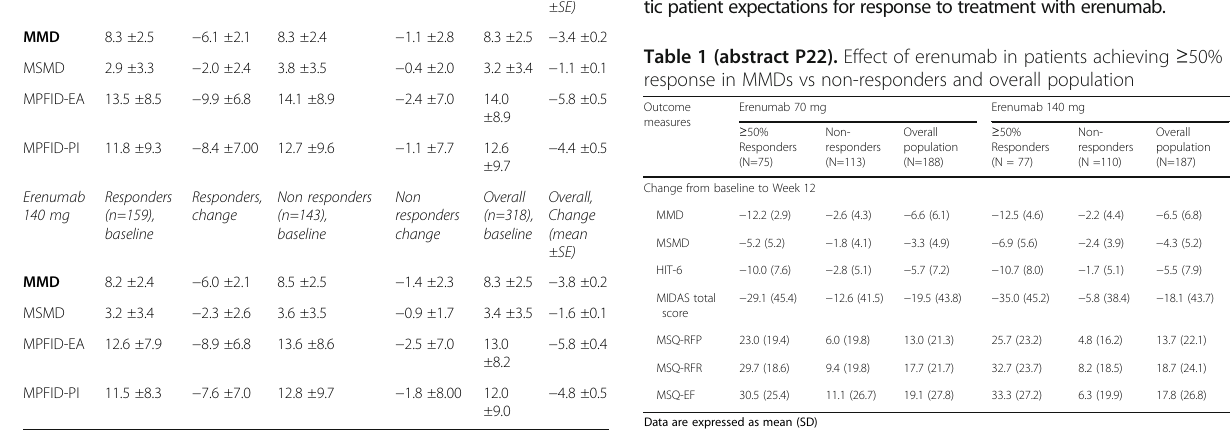
Table 1 (abstract P21). Primary and secondary outcome measures in erenumab-treated responder and nonresponder subgroups in STRIVE Erenumab Responders 70 mg